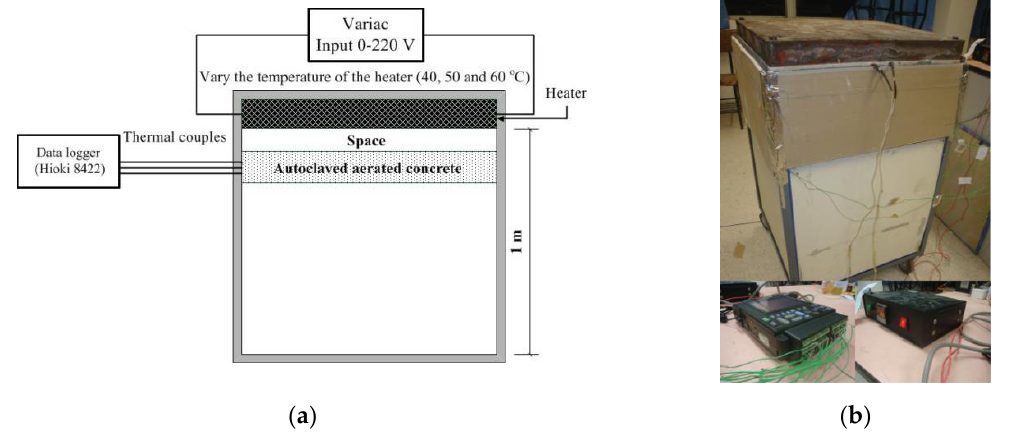
Figure 1. ( a ) Schematic diagram of the experimental set up. ( b ) View of the testing room and instrument installation. Materials 2019 , 12 , x FOR PEER REVIEW